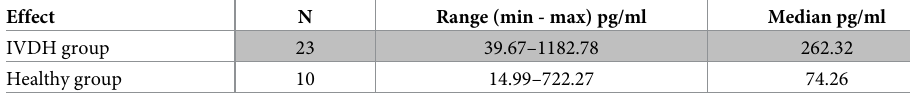
Table 3. IL-17 levels measured in serum